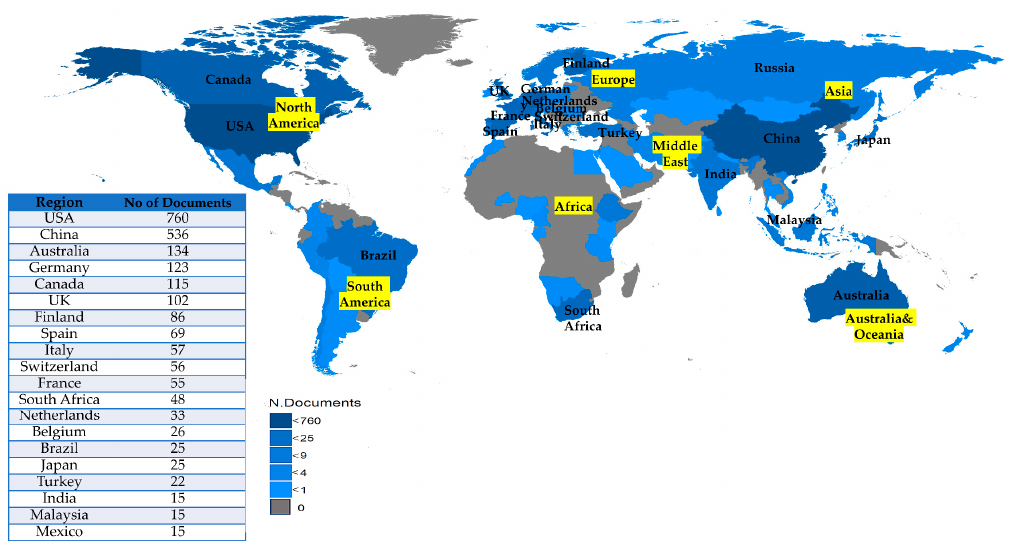
Figure 3. Most productive countries study on the fractional cover of forest algorithms.